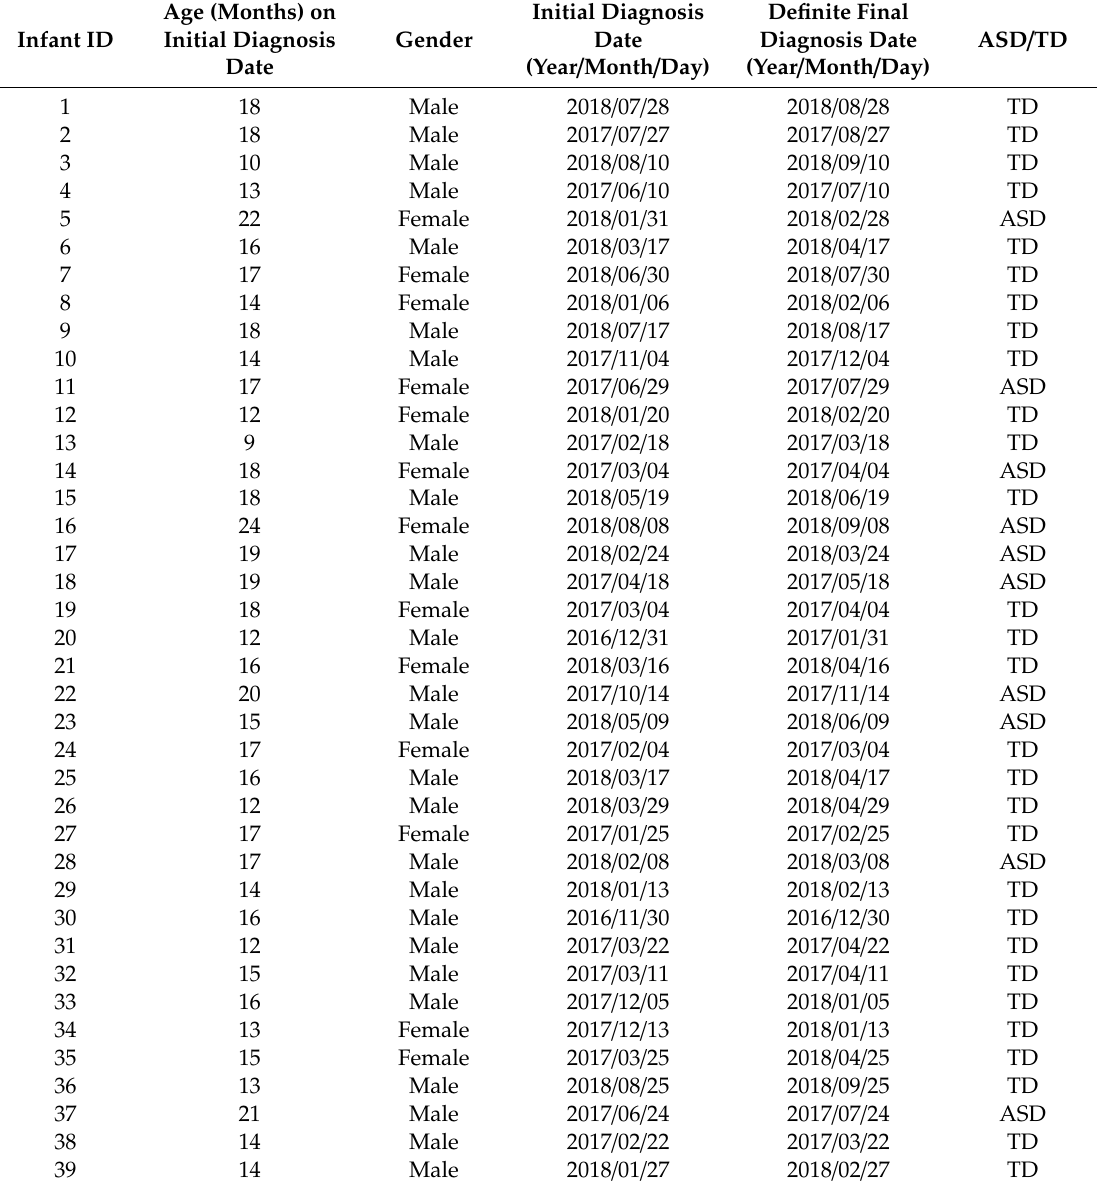
Table 2. Detailed information on the age, gender, and initial and definite diagnosis dates of each infant in Table